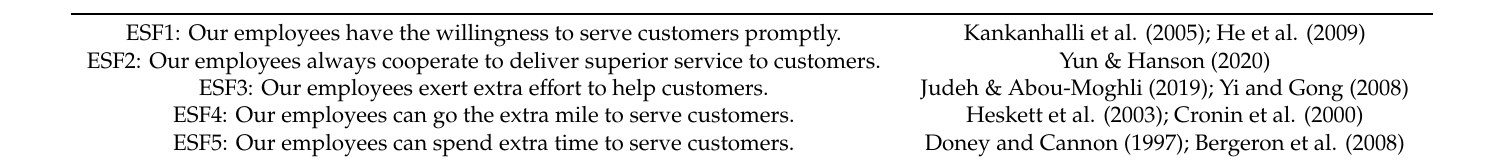
Table A3. Employees’ Self-e ffi cacy.